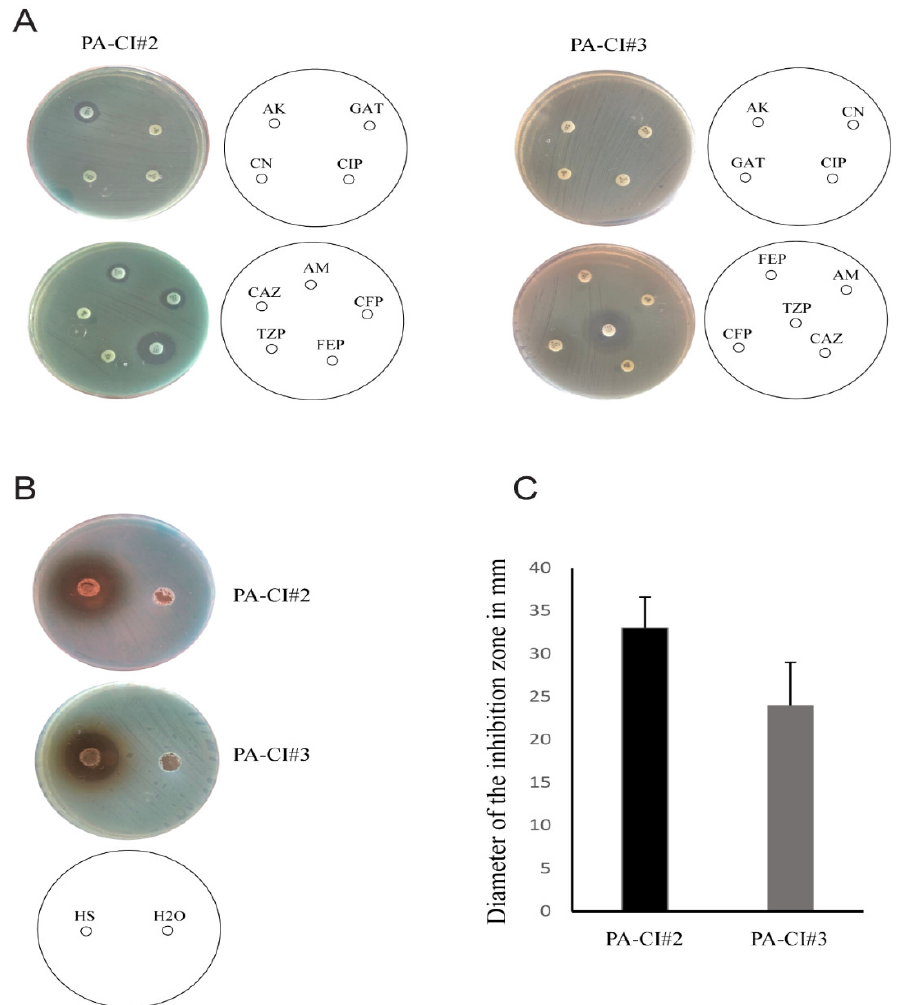
Figure 9. Antibacterial activity of HS ethanolic extract against multidrug resistant P. aeruginosa. ( A ) Antibiotic sensitivity by DDM of 2 clinical isolates of P. aeruginosa isolated from burn wound exudates against different antibiotics (bacterial isolate was defined as multidrug resistant when resistance against 3 or more categories of antibiotics was detected. Amikacin (AK, 30 µg), ampicillin (AM, 10 µg), ceftazidime (CAZ, 30 µg), cefoperazone (CFP, 75 µg), ciprofloxacin (CIP, 5 µg), gentamicin (CN, 10 µg), cefepime (FEP, 30 µg), gatifloxacin (GAT, 5 µg), and piperacillin/tazobactam (TPZ, 110 µg). ( B ) Bactericidal activity of HS ethanolic extract by cut-well agar diffusion against the 2 bacterial isolates in A. ( C ) Diameters of the zone of inhibitions in B (the bar indicates the mean of 3 independent experiments ± standard deviation).